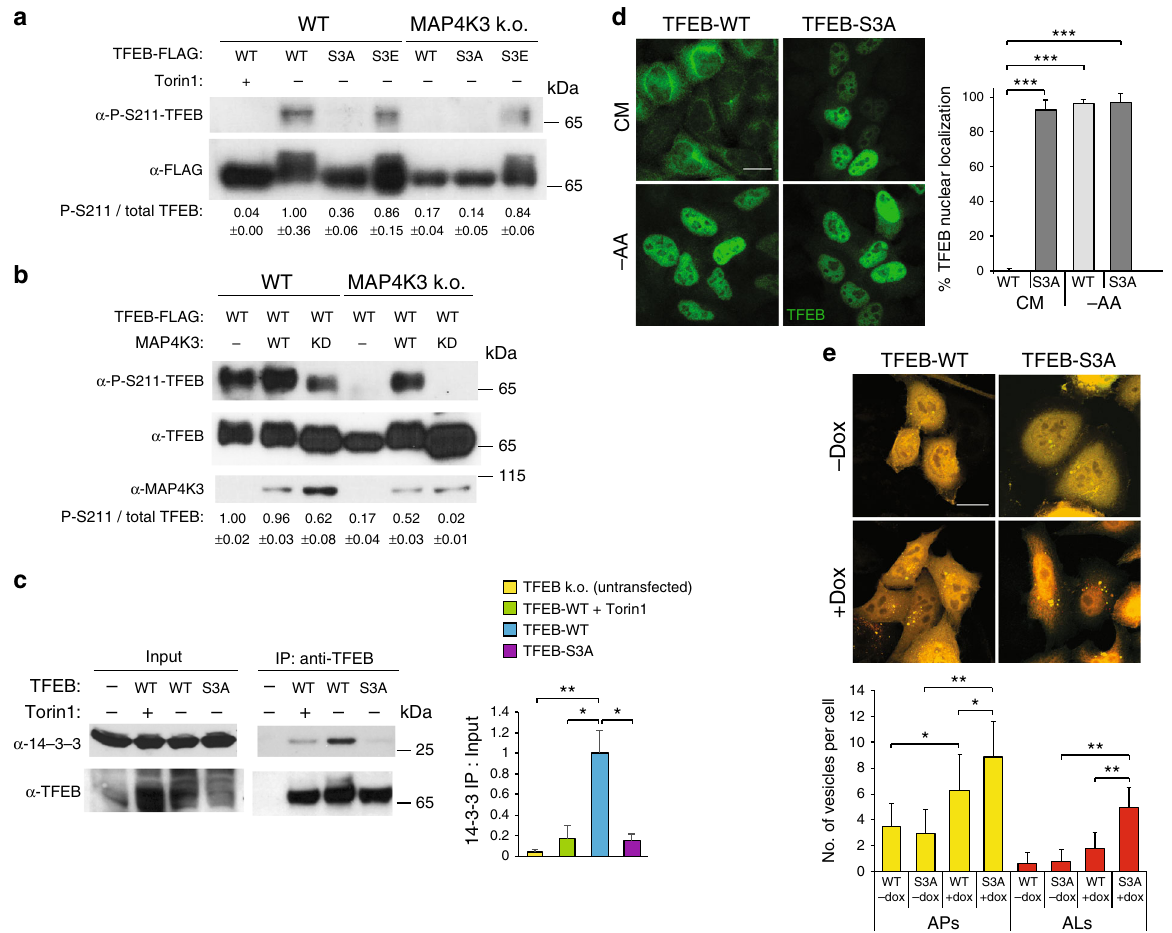
Fig. 6 Phosphorylation of TFEB at serine 3 is a key determinant of TFEB cellular regulation and autophagy function. a TFEB serine 3 phosphorylation is required for mTORC1 phosphorylation at serine 211. WT HEK293A and MAP4K3 k.o. cells were transfected with TFEB-FLAG, TFEB-S3A-FLAG, or TFEB- S3E-FLAG, and Torin1 treated. FLAG immunoprecipitates were immunoblotted and TFEB serine 211 phosphorylation as a fraction of total TFEB was quanti fi ed by densitometry. b MAP4K3 phosphorylation of TFEB is required for mTORC1 phosphorylation at serine 211. WT HEK293A and MAP4K3 k.o. cells were transfected with TFEB-FLAG and either no MAP4K3 (--), WT-MAP4K3, or KD-MAP4K3. FLAG immunoprecipitates were immunoblotted, and TFEB serine 211 phosphorylation as a fraction of total TFEB was quanti fi ed by densitometry. c TFEB serine 3 phosphorylation is required for interaction with 14-3-3. TFEB k.o. cells were transfected with no TFEB (--), inducible TFEB-WT-FLAG, or inducible TFEB-S3A-FLAG, and Torin1 treated, whereas all cells received doxycycline to induce TFEB-WT or TFEB-S3A expression. Cell lysates and TFEB immunoprecipitates were immunoblotted and immunoprecipitated 14-3-3 was quanti fi ed by densitometry. One-way ANOVA with post-hoc Tukey ’ s test; * P < 0.05, ** P < 0.01. d TFEB serine 3 phosphorylation regulates TFEB nuclear localization. TFEB k.o. cells were transfected with inducible TFEB-WT-FLAG or TFEB-S3A-FLAG, and cultured in CM or amino-acid starved ( – AA). Under amino acid deprivation, TFEB localizes to nucleus, regardless of serine 3 status; however, upon amino acid satiety, mutation of TFEB serine 3 to phospho-resistant alanine prevents retention of TFEB in the cytosol. Quanti fi cation of TFEB nuclear localization to right. n > 100 cells per condition. One-way ANOVA with post-hoc Tukey ’ s test; *** P < 0.001. e TFEB serine 3 phosphorylation regulates autophagy activation. TFEB k.o. cells were transfected with GFP-mCherry-LC3 and either inducible TFEB-WT-FLAG or TFEB-S3A-FLAG, and cultured in CM and doxycycline, as indicated. Note the red puncta indicative of autolysosomes in cells expressing TFEB-S3A. Autophagosome number per cell was determined by counting yellow puncta per GFP-mCherry-LC3-expressing cell, and autolysosome number per cell was determined by counting red puncta per GFP-mCherry-LC3- expressing cell. n > 50 cells per condition. One-way ANOVA with post-hoc Tukey ’ s test; * P 0 < 0.05, ** P < 0.01. All experiments performed in triplicate. Error bars = SEM. Scale bars = 20 μ m